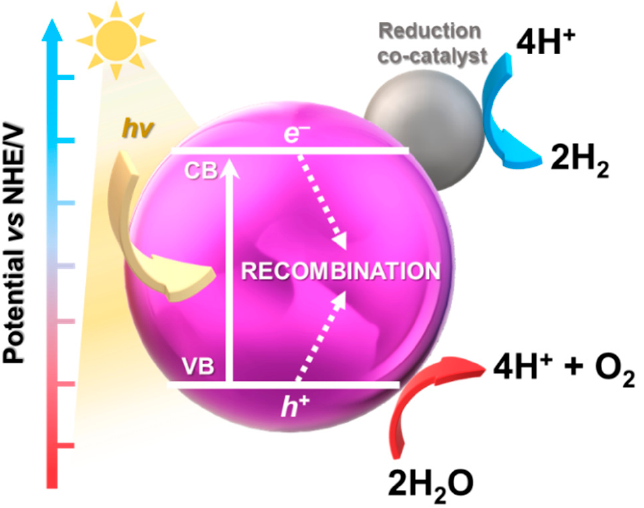
Figure 8. Scheme of light-triggered water splitting over a semiconductor photocatalyst.